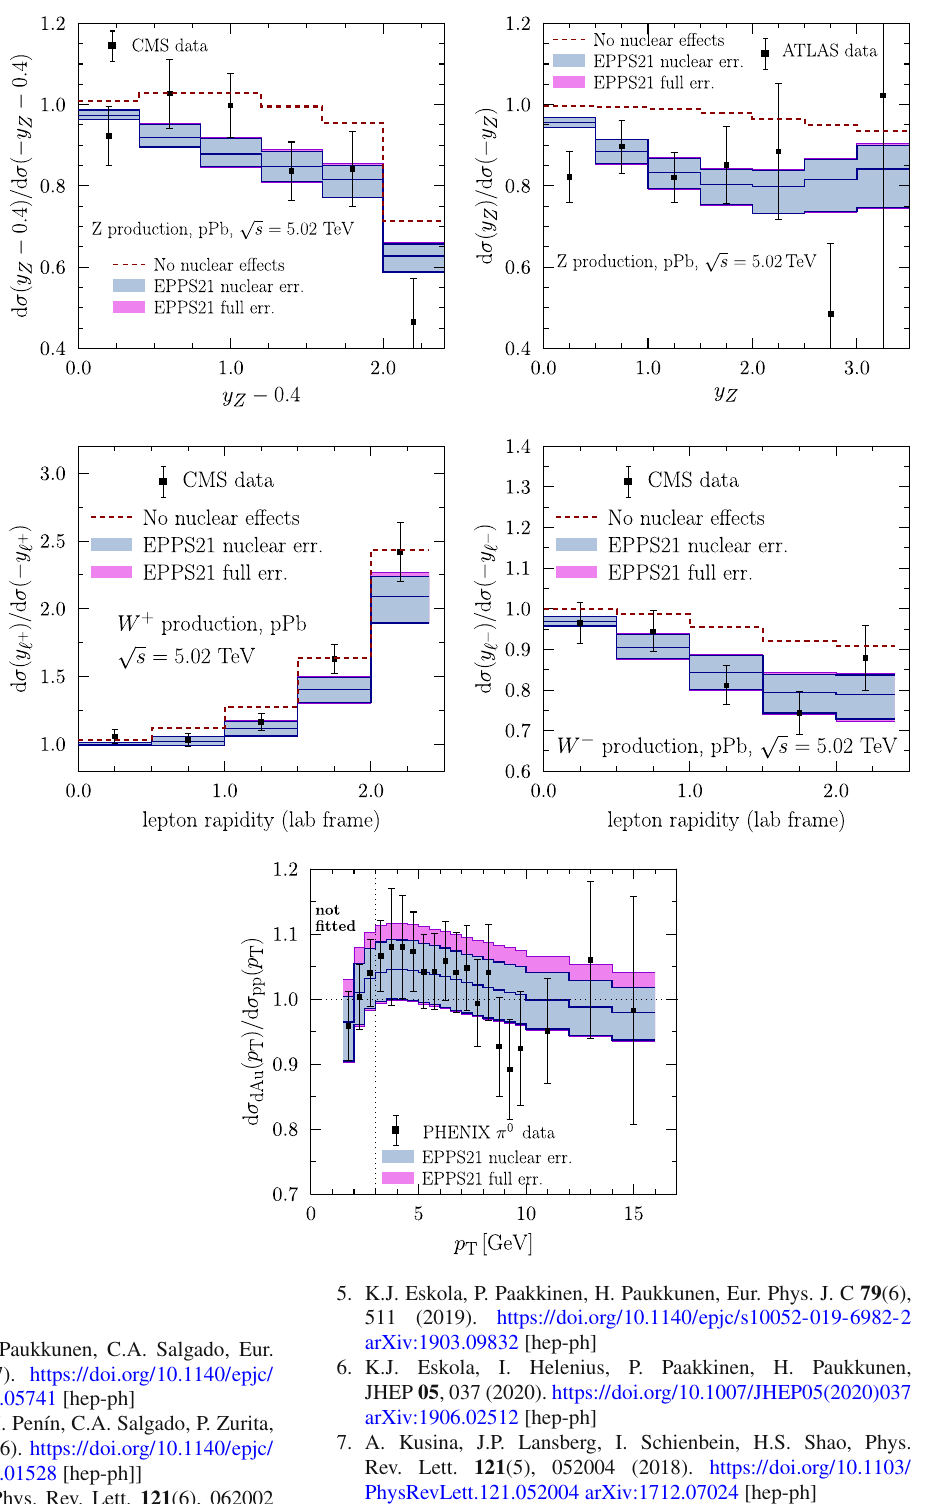
Fig. 27 The CMS and ATLAS 5TeV pPb data [60–62] for Z (upper panels) and W ± (middle panels), as well as PHENIX dAu cross-section ratios for inclusive pion production [80] (lowest panel) compared with the EPPS21 analysis. The solid blue lines show our central results, inner blue bands the nuclear uncertainties, and the purple bands the total